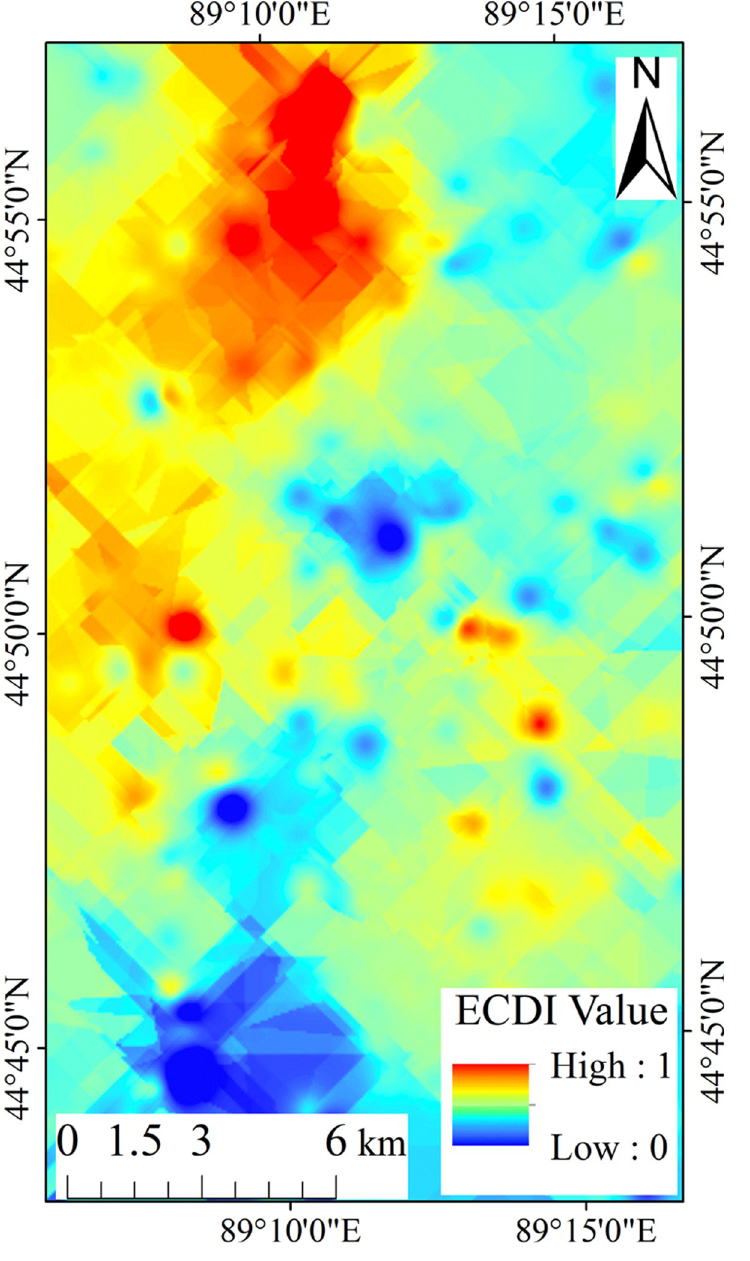
Fig 6. Kriging interpolation image for the